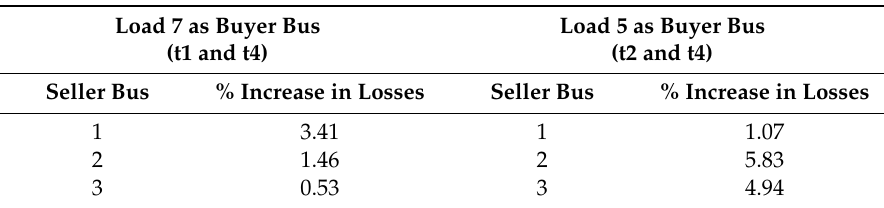
Table 5. Increase in % losses at different buses.